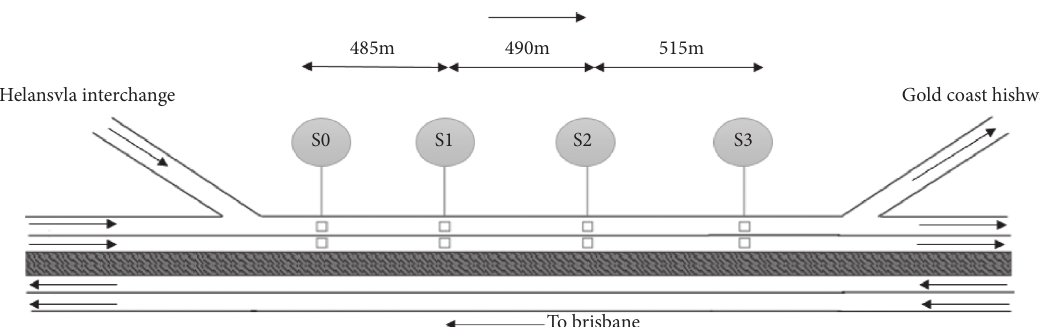
Figure 1: Schematic of the Pacific Motorway section used for collecting dataset 1 [40].